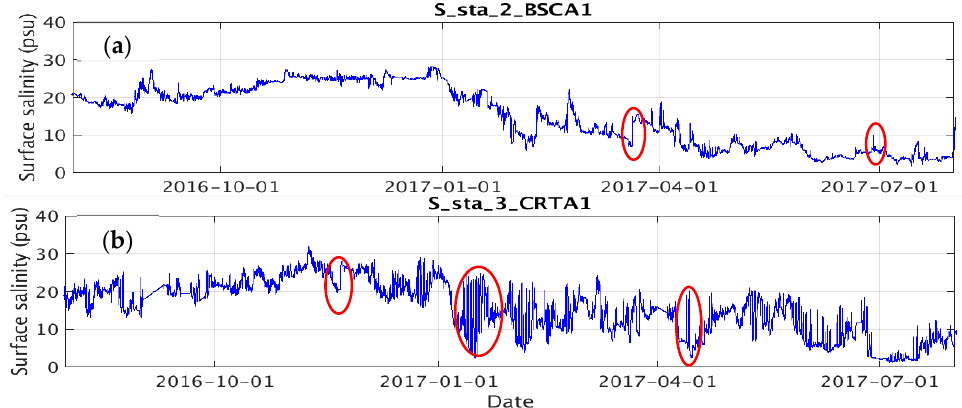
Figure 16. The observed surface salinity time series at stations ( a ) BSCA1 and ( b ) CRTA1. Red ellipses marked occurrences the sensor false measurements.